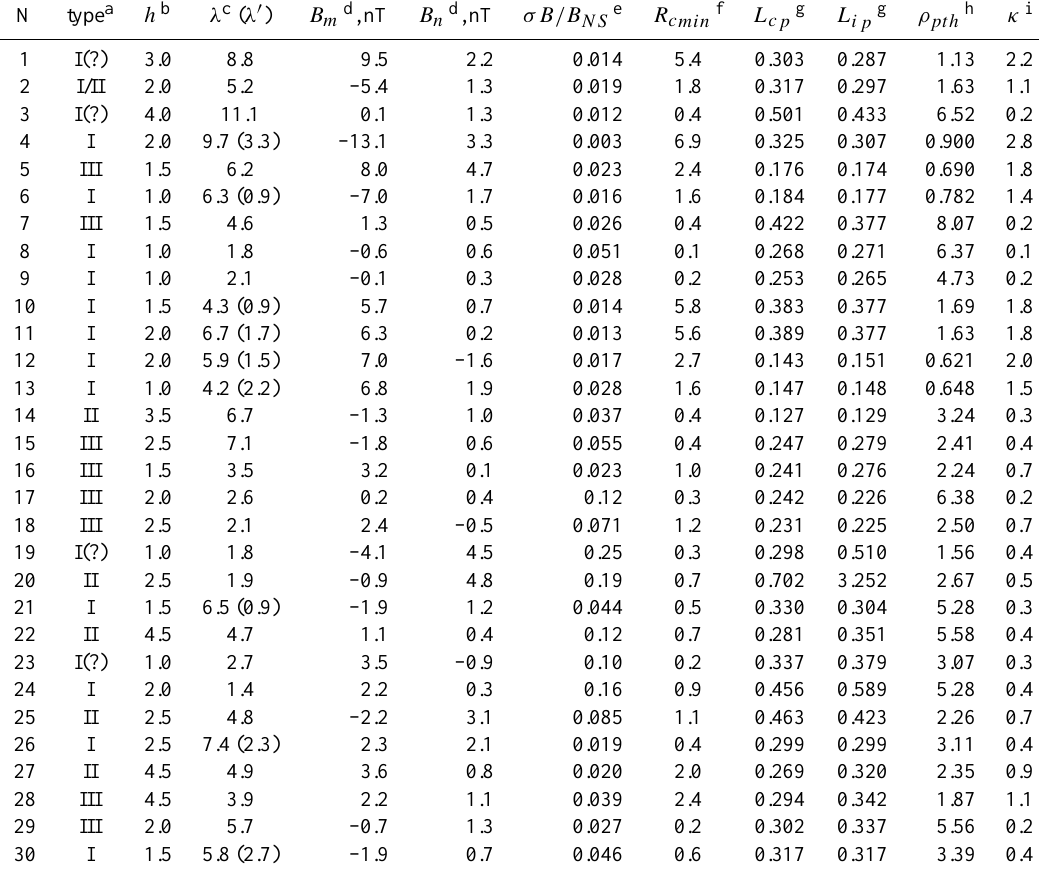
Table 3. Current sheet